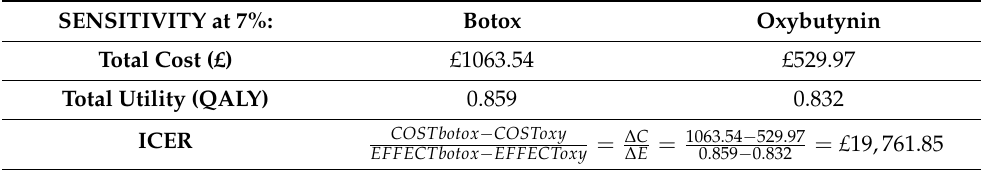
Table 6. Sensitivities of Botox and oxybutynin at